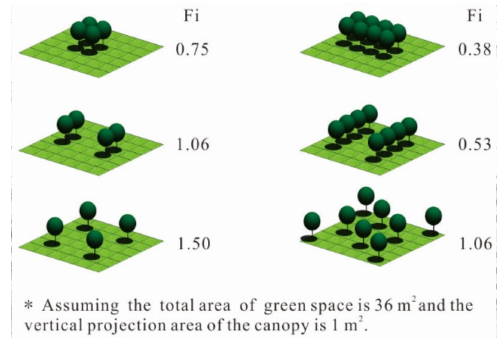
Figure 2. Examples of the landscaping isolation index F i for different distribution patterns of